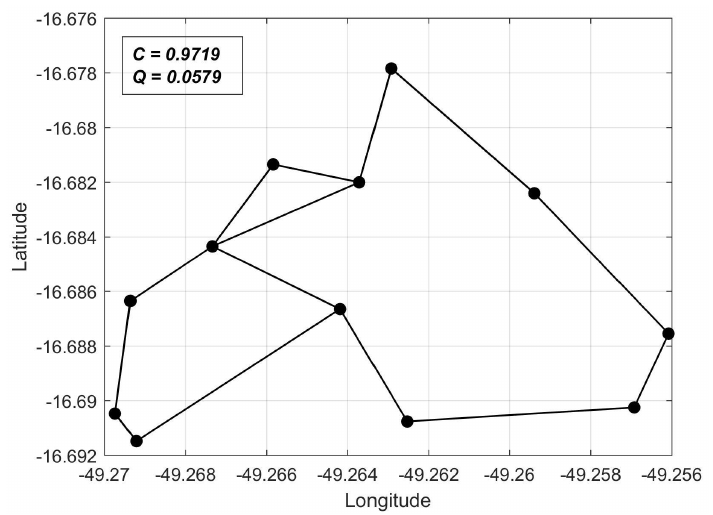
Figure 3. Solution S 1 with high reliability in Q - C space.